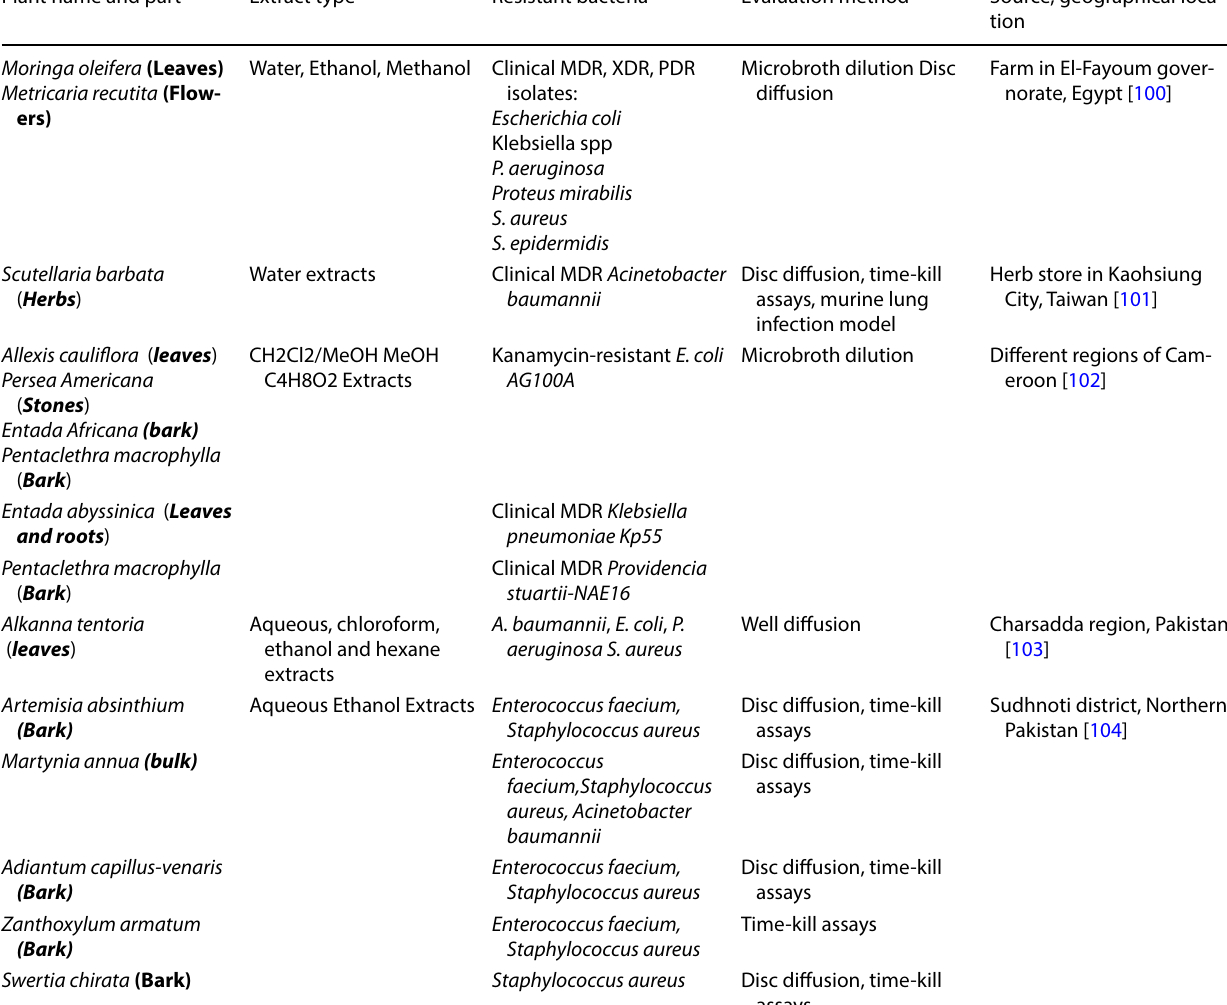
Table 1 Examples of plants with known activity against multidrug-resistant pathogens. These plant-based metabolites provide promising option to develop novel drugs against multidrug-resistant pathogens Plant name and